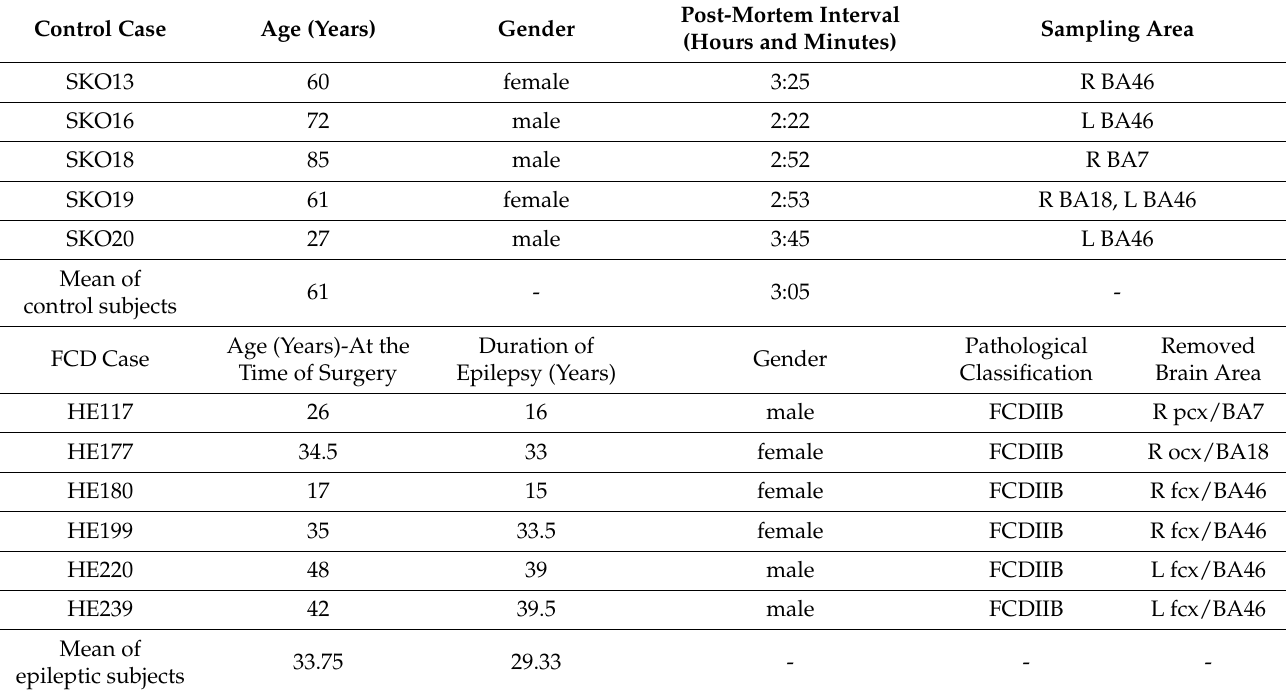
Table 1. Data of the control and FCD patients involved in the quantitative